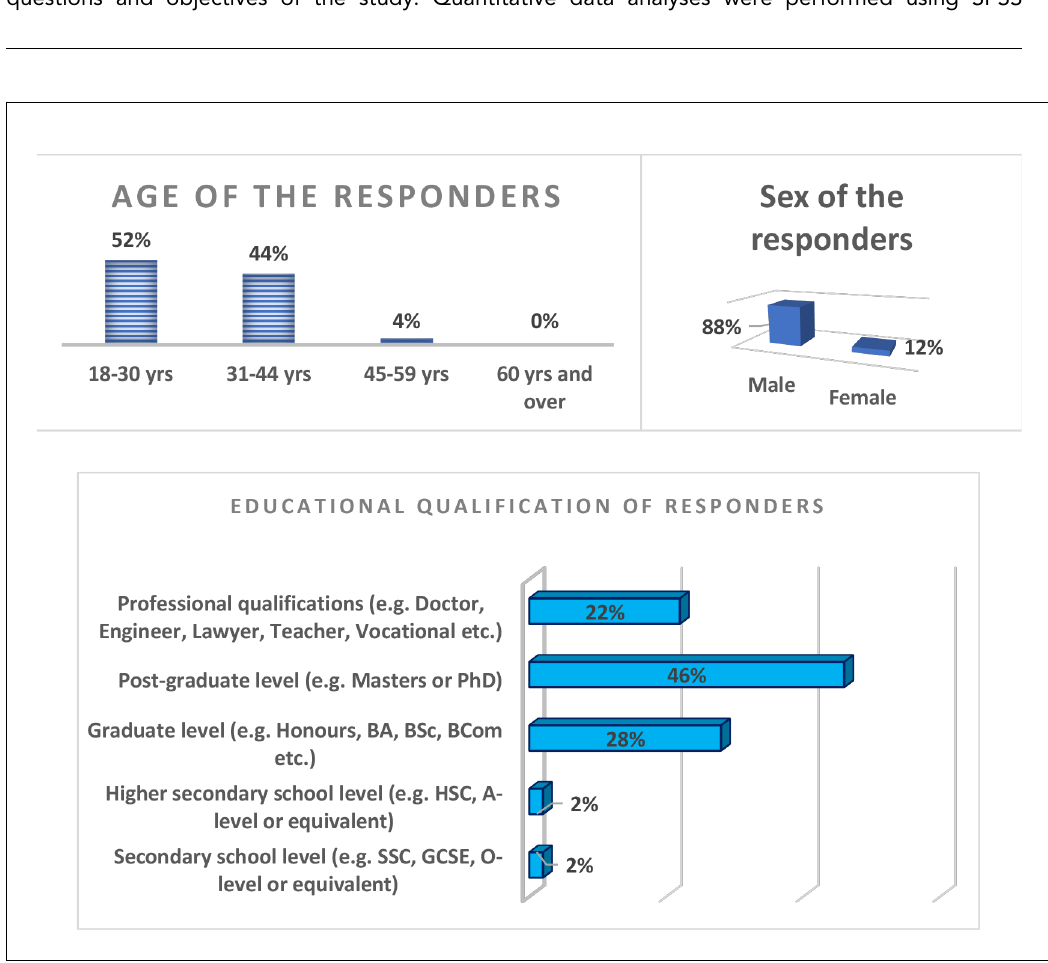
Figure 1. Sociodemographic characteristics of the study